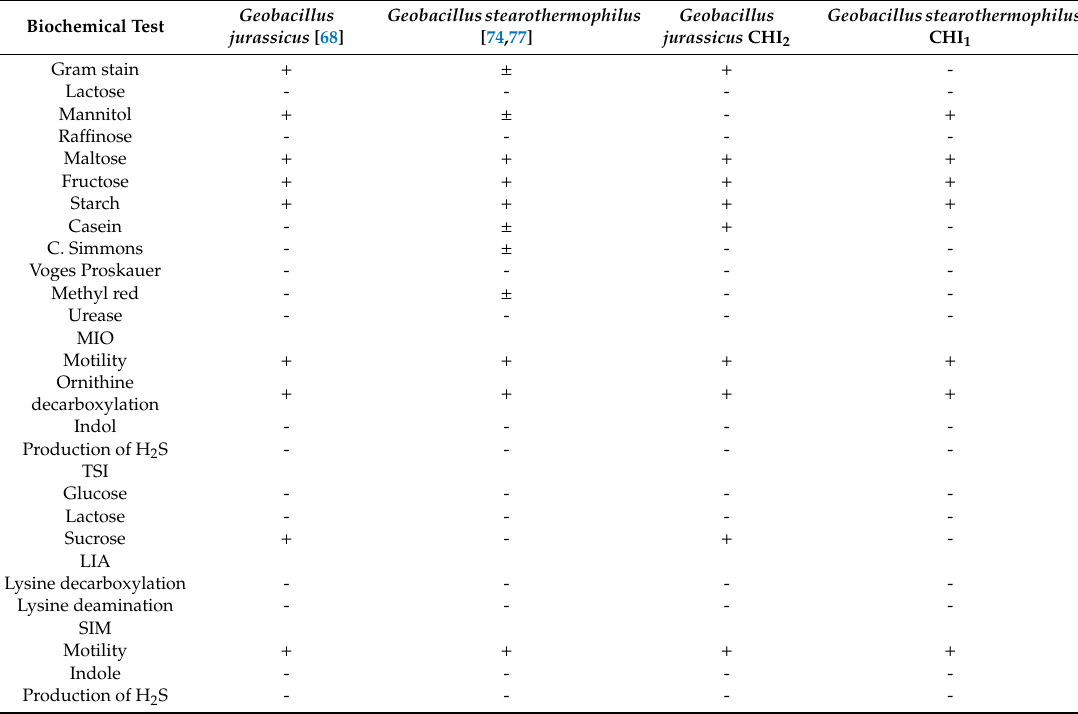
Table 1. Biochemical tests result of the strains G. jurassicus CHI 2 and G. stearothermophilus CHI 1 . Biochemical